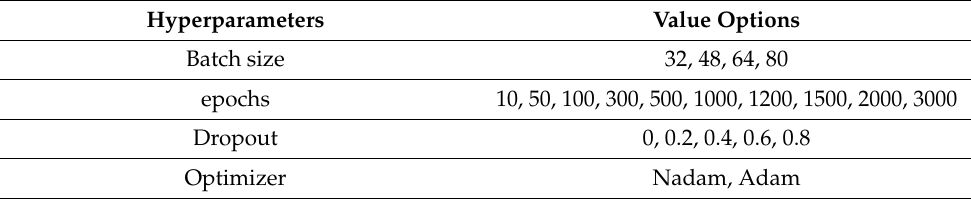
Table 1. Options for hyperparameters optimization.